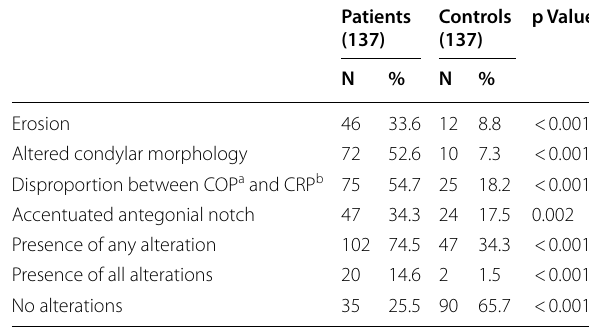
Table 1 Demographic data of patients with juvenile idiopathic arthritis and control group and clinical data of patients